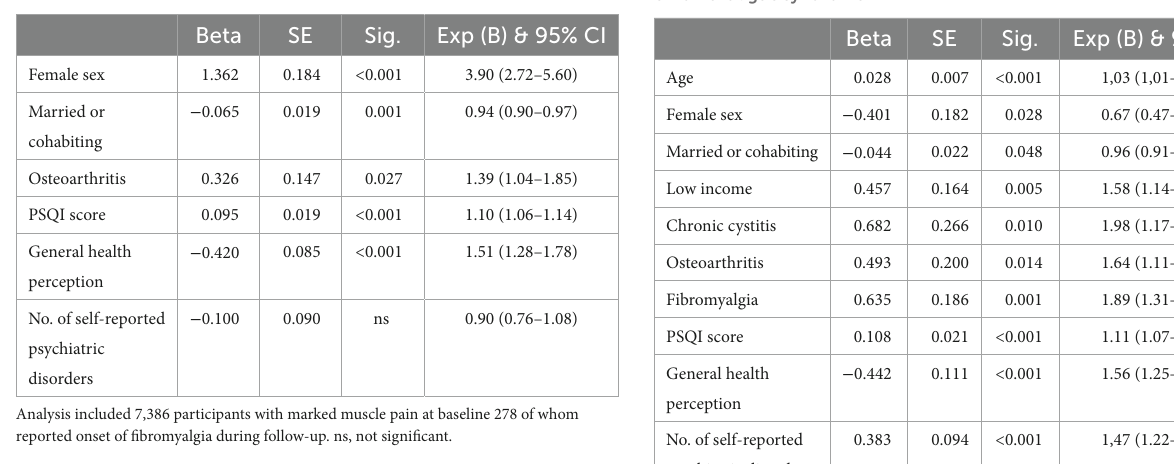
TABLE 5 Logistic regression to identify predictors of self-reported fibromyalgia.